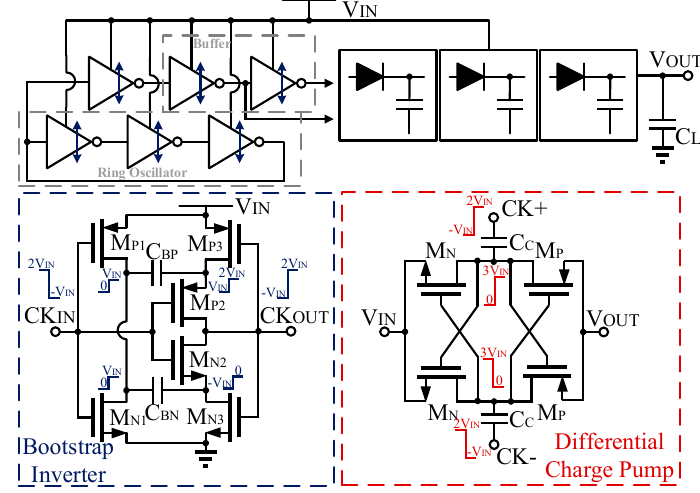
Figure 3. Schematic of proposed photovoltaic and thermoelectric energy-harvesting circuit.